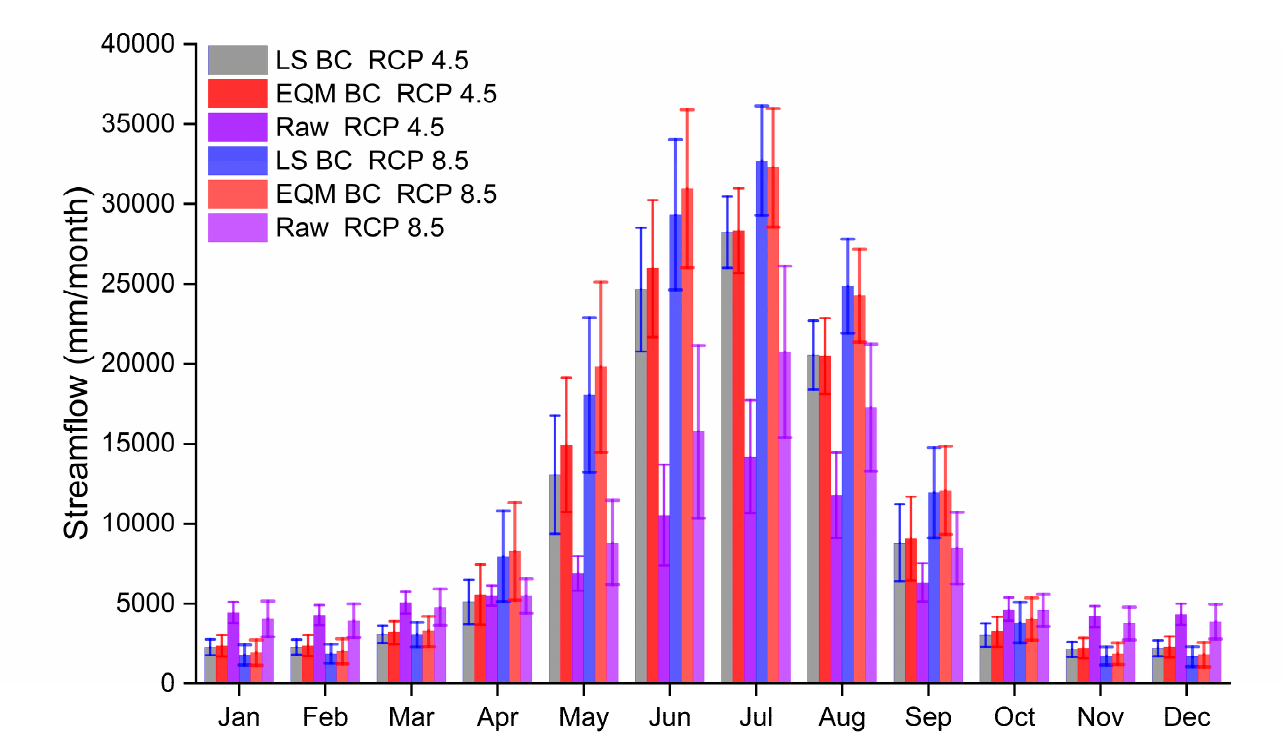
Figure 12. As Figure 7, but for the period 2070–2099. The impacts of LS- and EQM-bias correction methods on the 7-day minimum and maximum streamflow and 10th and 90th percentile streamflow for far future period (2070–2099) under the RCP 4.5 and RCP 8.5 emission scenarios are assessed with the help of Figures 13 and 14, respectively. The raw NEX-GDDP models depict higher values for 7-day minimum streamflow than the LS- and EQM-corrected ones. On the other hand, the 7-day maximum streamflow, simulated using raw NEX-GDDP, was lower than the one obtained using the LS- and EQM-corrected NEX-GDDP models. In addition, the 10th and 90th percentile streamflow, simulated with the raw NEX-GDDP models, was also projected to be substantially lower in the wet period and higher for rest of the year, as compared to the values obtained with bias-corrected data, which seem much more realistic.